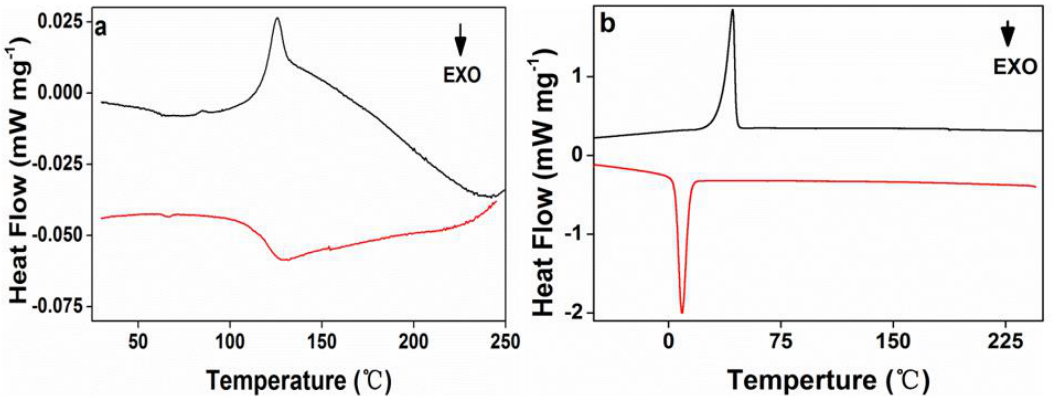
Figure 6. The second differential scanning calorimetry (DSC) heating and cooling curves for ( a ) acrylic rosin and ( b ) PEG-acrylic rosin aggregation obtained at 5 °C.